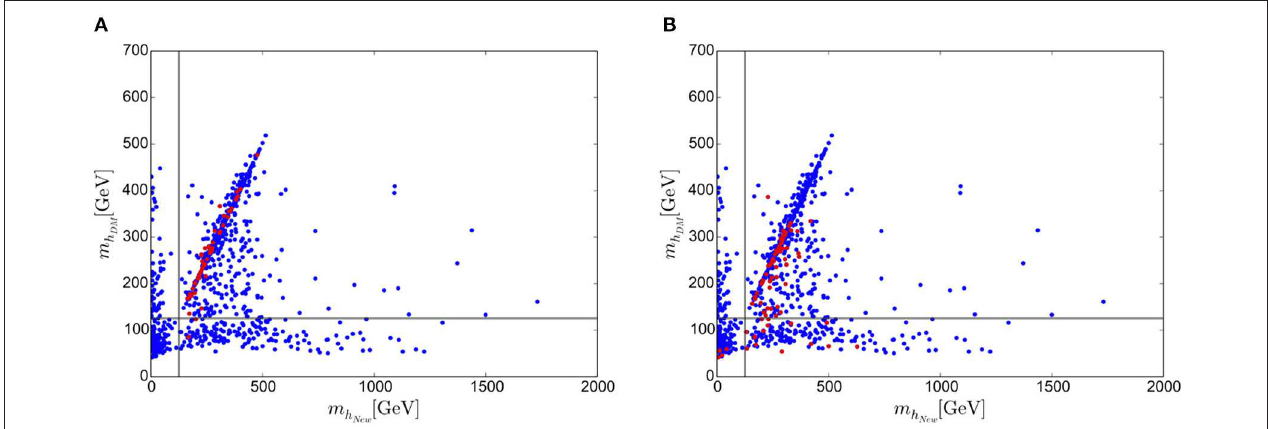
< 0.05 at M Pl . The gray bands highlight the SM Higgs mass range. 2 < 0.01. These plots originally appeared in 2